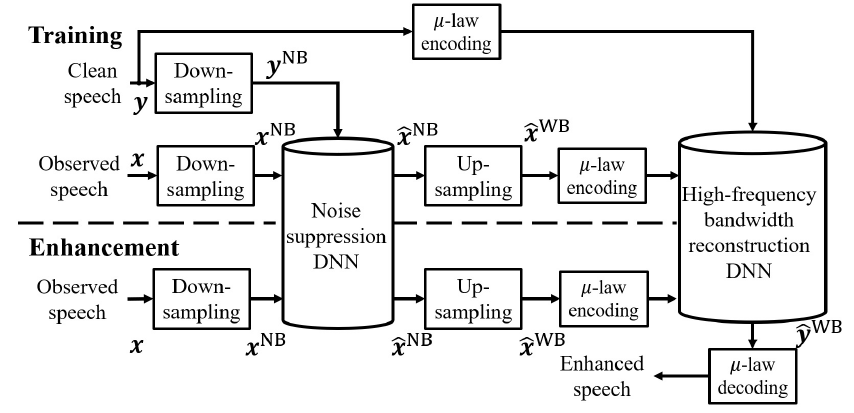
Figure 6. Block diagram of the proposed waveform-based method.